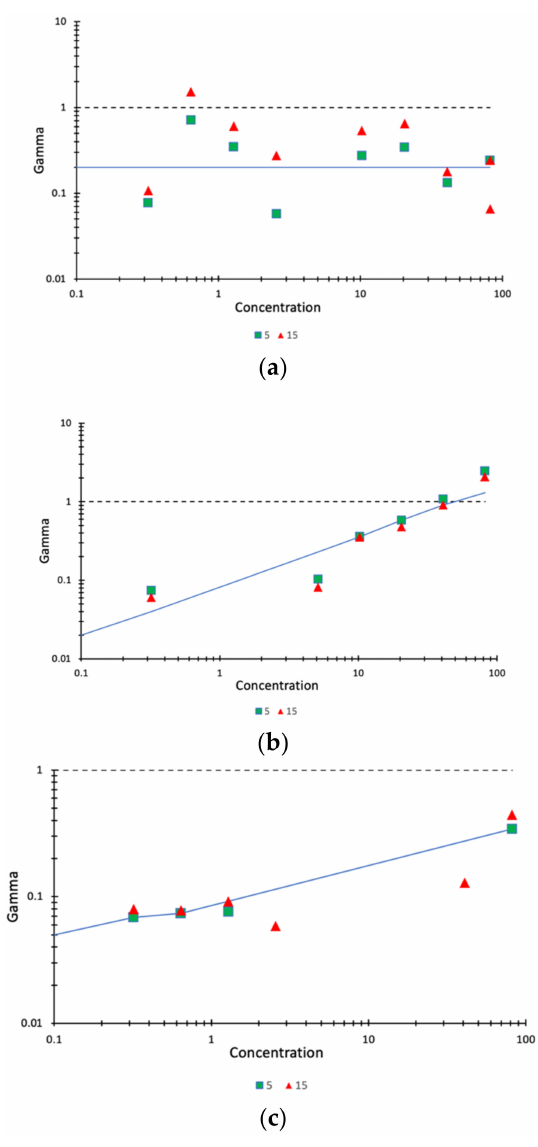
Figure 6. Aquatic toxicity test results for Picea ( a ), Molinia caerulea ( b ) and Elaeis guineensis ( c ). Gamma = 1 corresponds to the EC50. Horizontal axis corresponds to the percentage of the concentra- tion, where 100% equals 1000